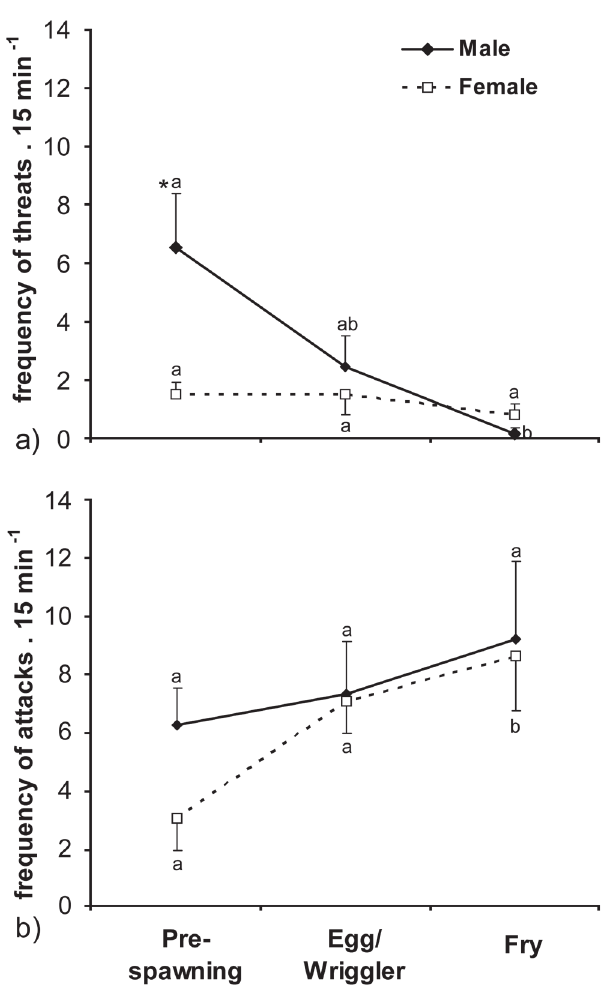
Fig. 5. Mean frequency (± SE) of threats ( a ) and attacks ( b ) given by male and female in the pre-spawning (n = 11), egg/ wriggler (n = 11) and free-swimming fry (n = 12) phases. * indicates significant difference between sexes (Wilcoxon signed-rank test). Different letters indicate significant differences between phases for each sex (Kuskal-Wallis followed by Dunn post hoc